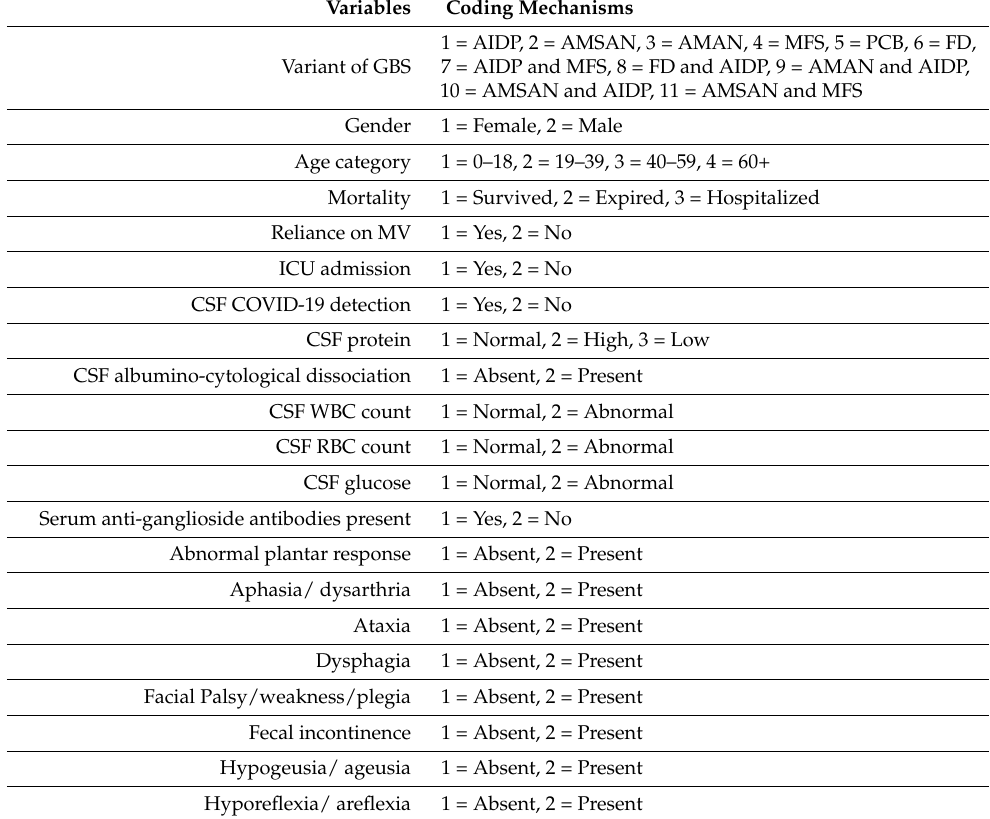
Table A2. Coding